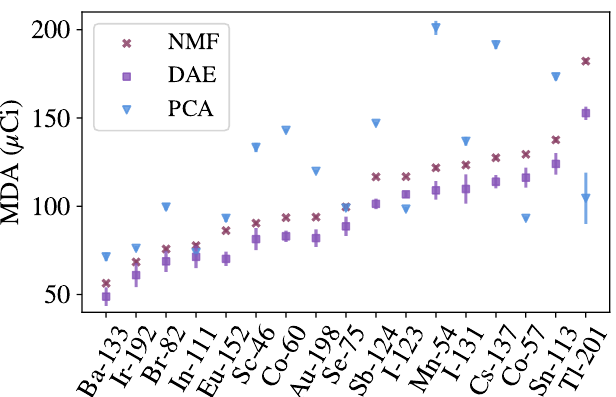
Figure 6. Comparison of MDA for the three detection methods across all 17 sources at a 1/8 h − 1 FAR. Sources are sorted in ascending order MDA for the baseline NMF method. Each model was evaluated by injecting each source type across activities into each run of the background test set and computing the MDA. The background used, the test set, was separate from the training and validation background, and thus gives a sense of how well each model generalizes to unseen background data. Note that the discrepancy between the PCA-based method and the other two is likely due to the detection metric used for the PCA-based approach, which comes from the literature. The error bars shown were computed by propagating uncertainties of µ and σ from Equation (8), estimated from the least squares fitting routine. Note that there is an overlap between DAE and PCA for 111 In and between NMF and PCA for 75